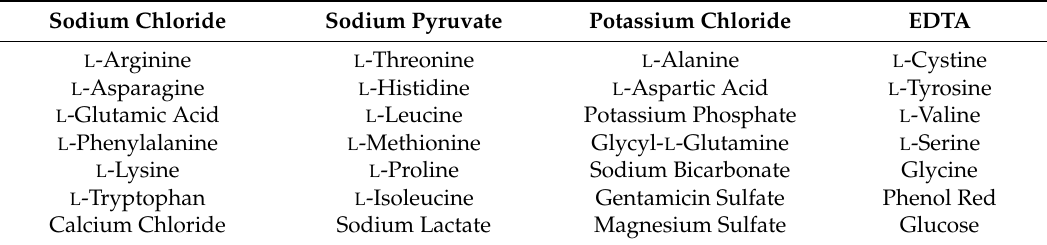
Table 1. Chemical composition of Global for fertilization